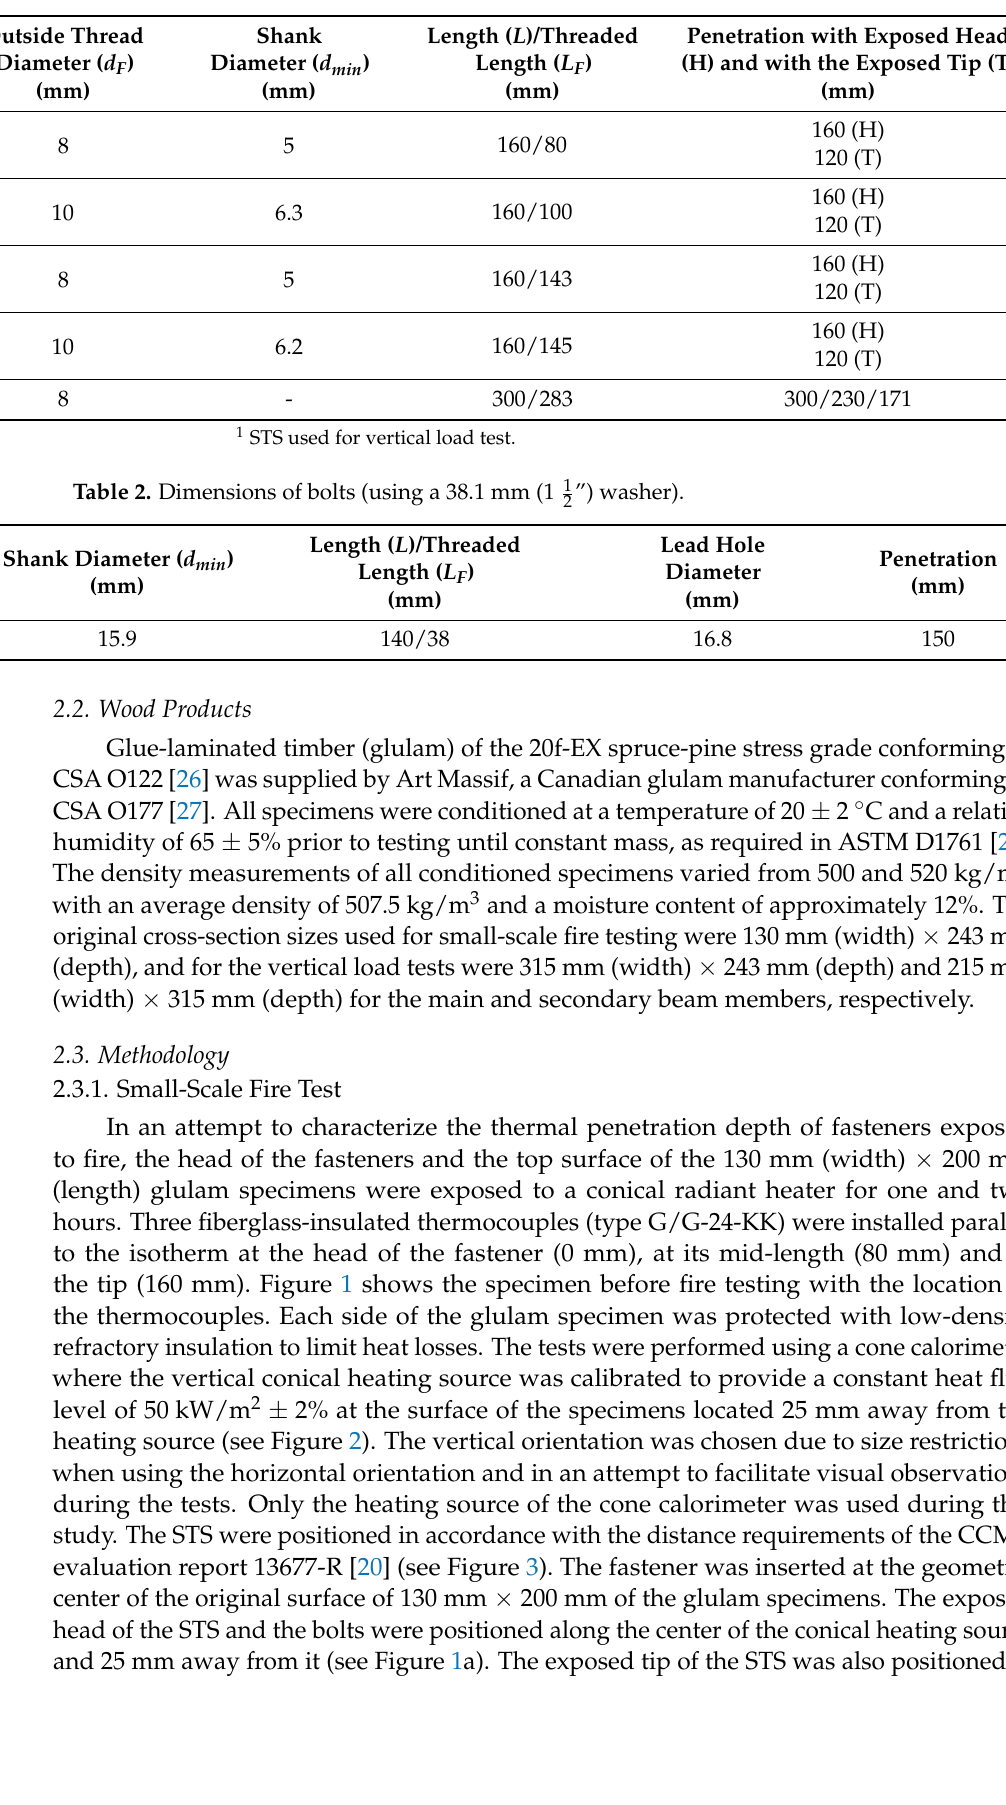
Table 1. Dimensions of self-tapping screws.